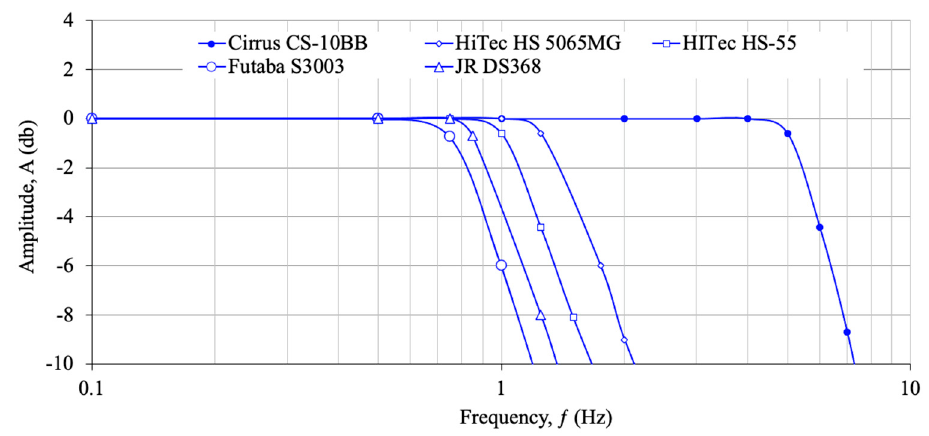
Figure 18. Typical subscale micro-servo actuator dynamic responses [24].